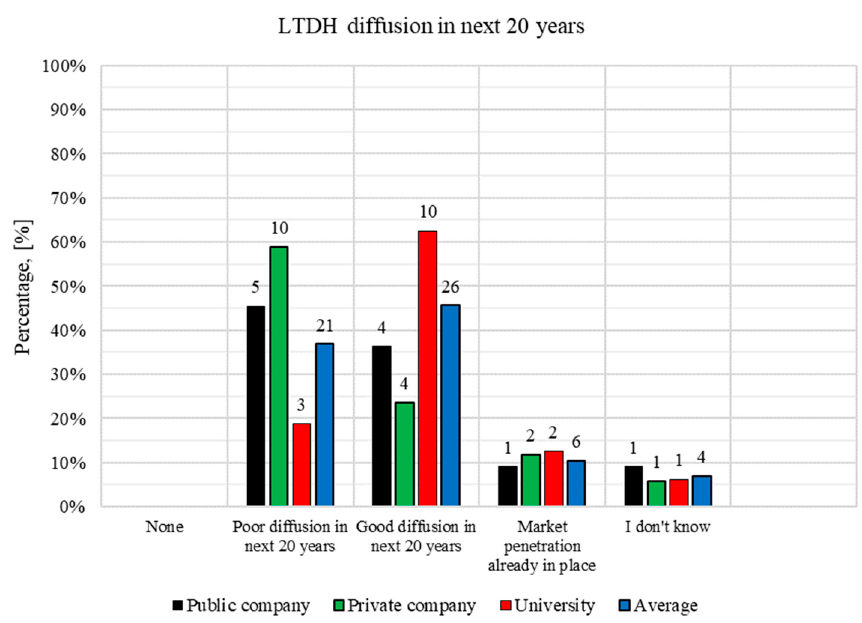
Figure 34 . LTDH concept diffusion over the next 20 years as a function of the organization type.